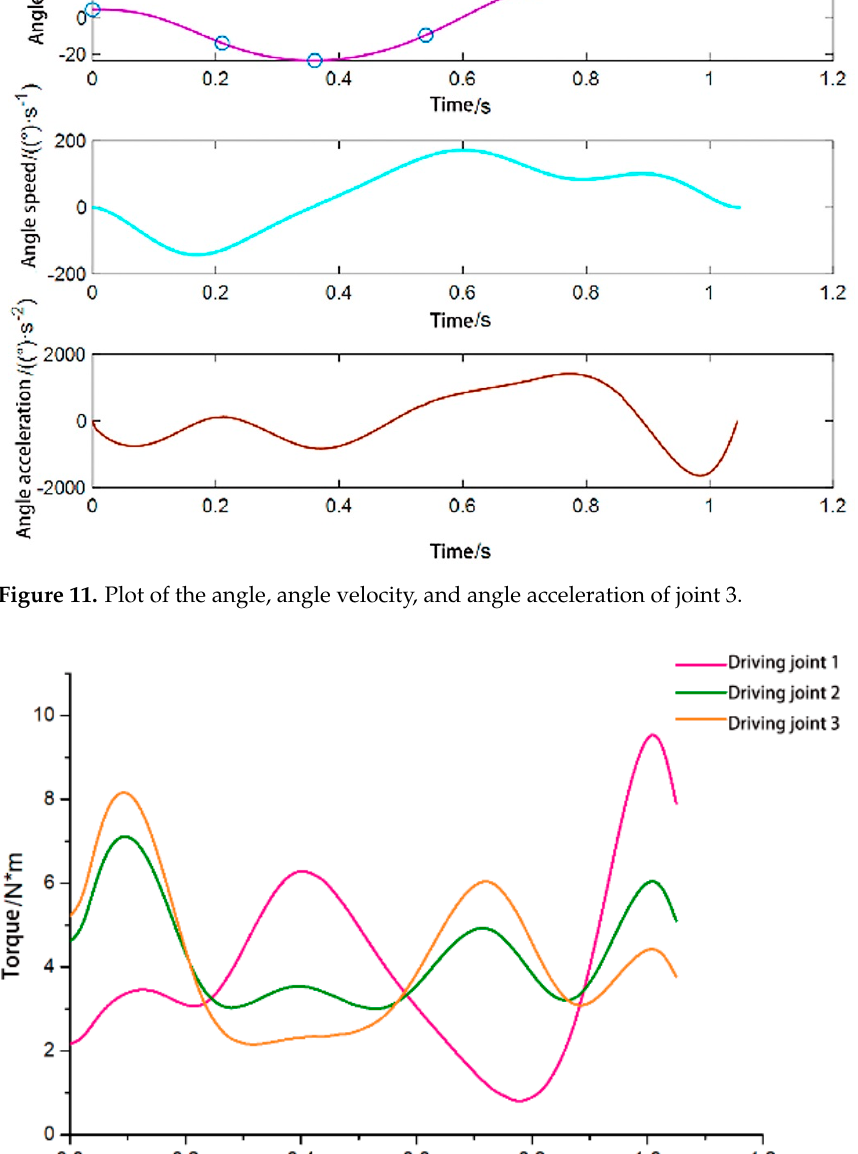
Figure 12. Torque change of each driving joint.